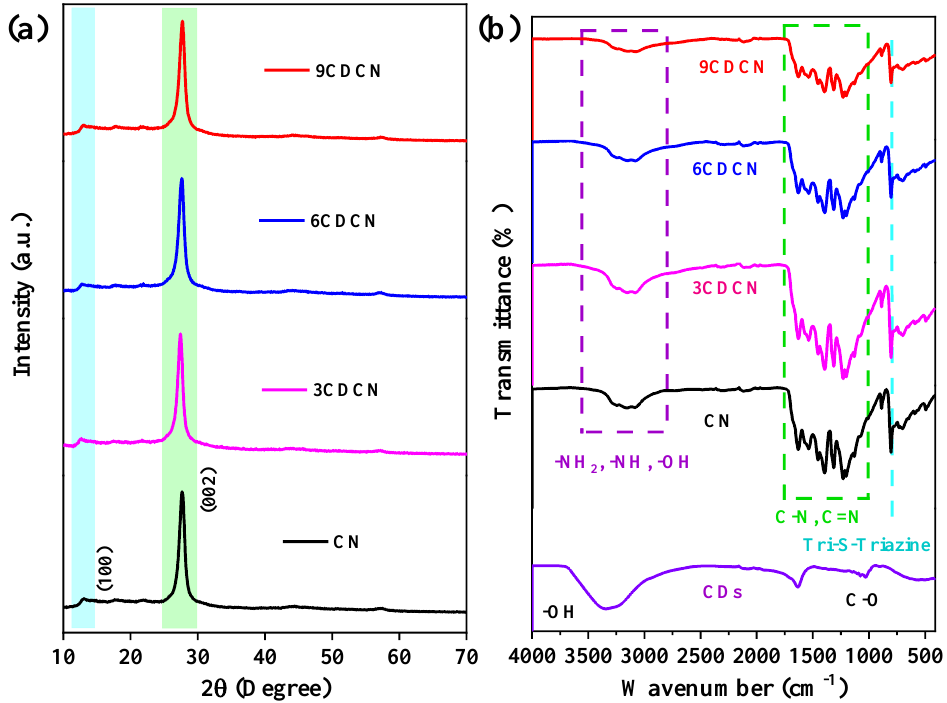
Figure 1. ( a ) The XRD pattern of CN, 3CDCN, 6CDCN, and 9CDCN, and ( b ) FT − IR spectrum of CDs, CN, 3CDCN, 6CDCN, and 9CDCN.